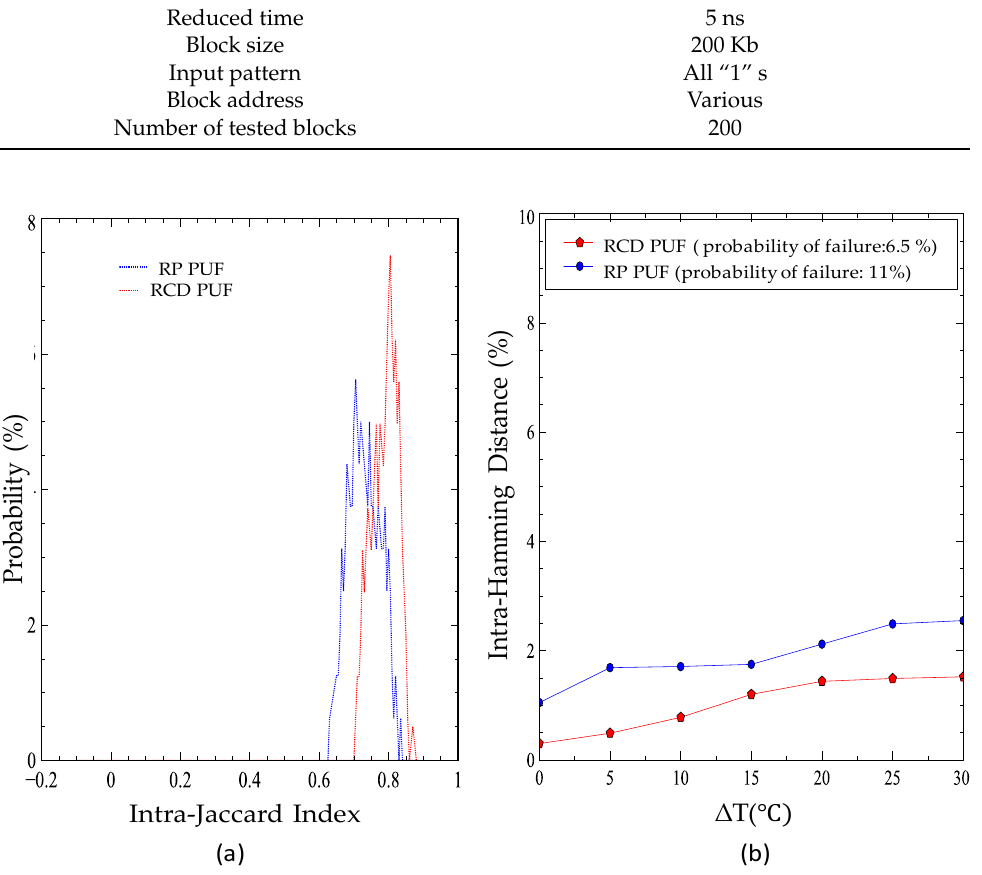
Figure 6. ( a ) Distributions of intra-Jaccard indices calculated between responses for t RCD and t RP PUFs. ( b ) The average intra-Hamming distance (HD) for t RCD and t RP PUFs with different temperatures (reference temperature is 25 °C).